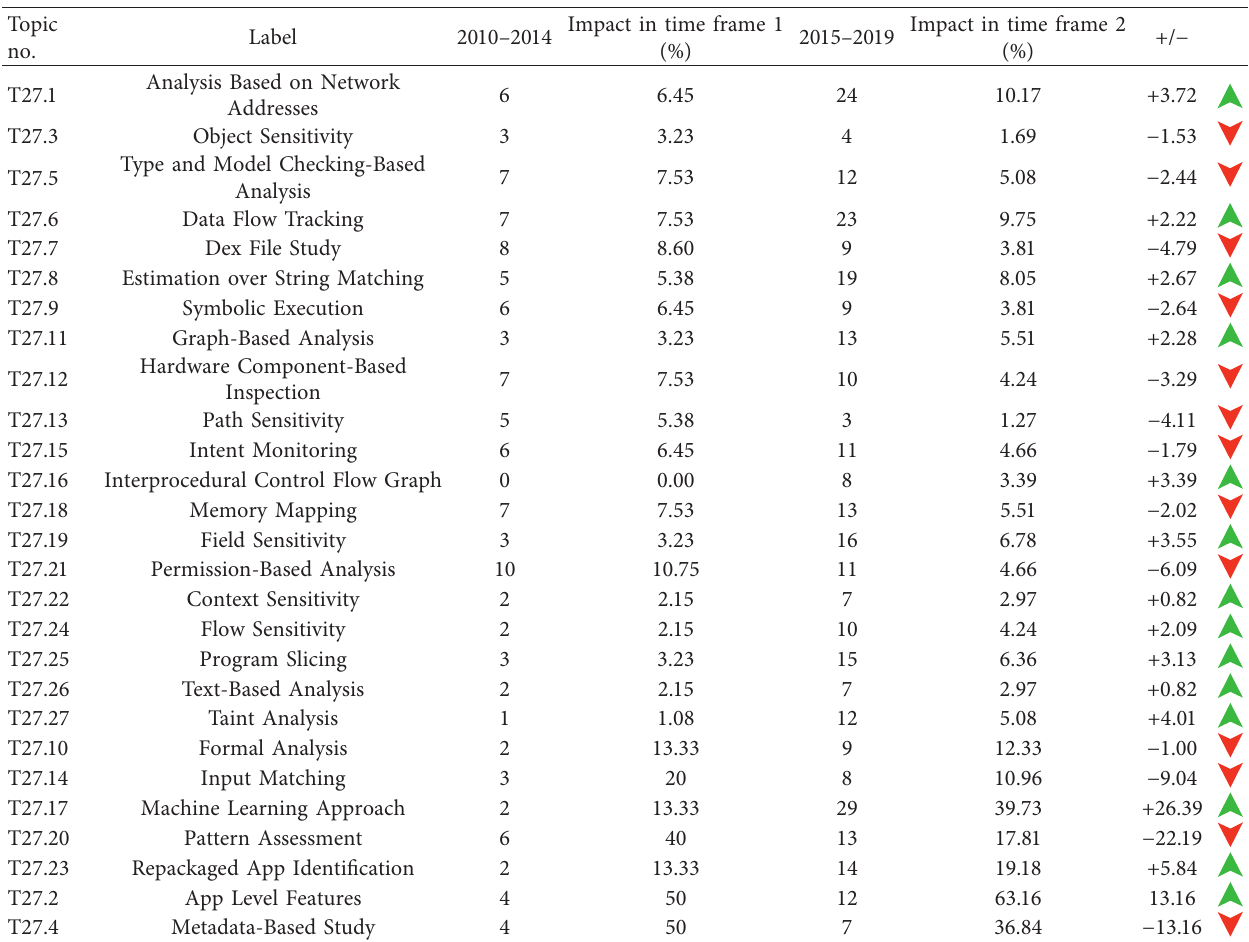
Table 9: Focus of topics changed over time from 2010 to